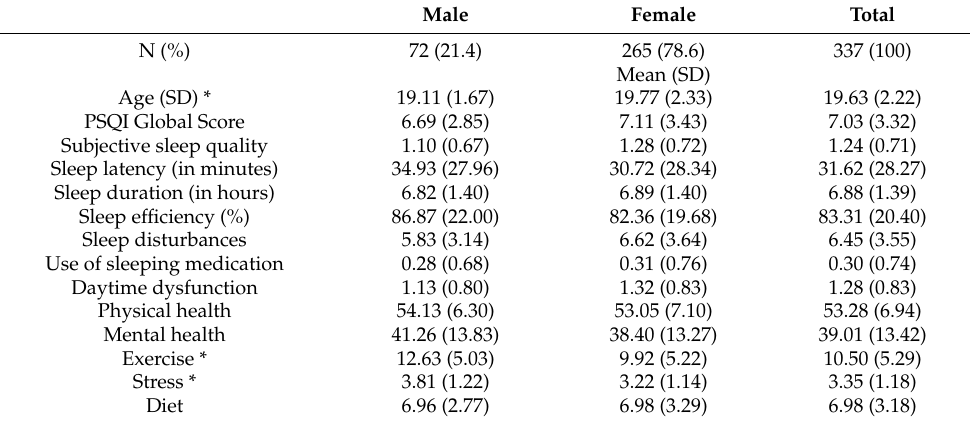
Table 1. Descriptive